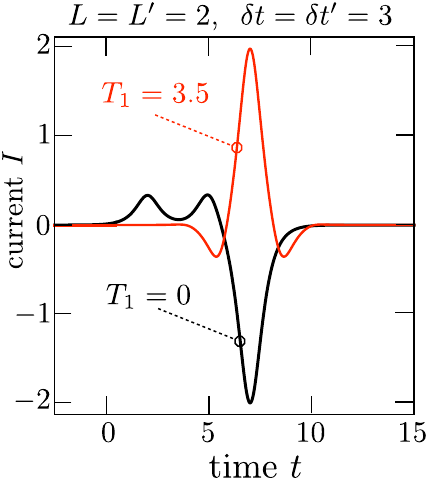
Figure 6: Time dependent current I ( t ) (in dimensionless units) in the geometry of Fig. 1. The superconducting phase is incremented from 0 to 2 π across Josephson junction A at time t = 0, and then back from 2 π to 0 across Josephson junction B at ( t ) = arccos ( − tanh2 t ) time t = T . The curves are calculated from Eq. (37), with α A 1 ( t ) = − α ( t − T ) . For the black curve we took T = 0, while for the red and α B A 1 1 = 3.5. The resulting sign switch of the current pulse curve we introduced a delay T 1 signals the braiding of the world lines of the injected vortices, as indicated in Fig. 5. The large peak (integrated charge ± e / 2) is from the fusion of vortices 1 and 2, the small side peaks come from vortices 3 and 4, which have little overlap and therefore only give a small contribution to the transferred